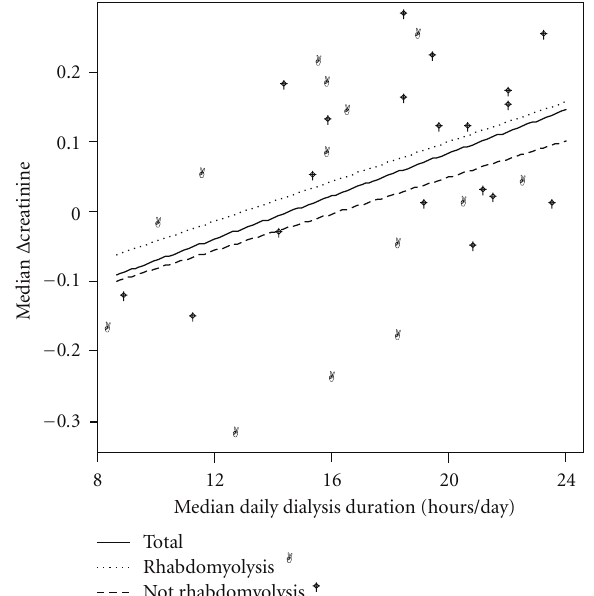
Figure 3: Scattergram of median daily CRRT duration and median Δ creatinine in the total population and the subgroups with and without rhabdomyolysis. Linear regression analysis showed a significant relationship between median daily CRRT duration and median Δ creatinine in the whole group, r = 0 . 43, P = 0 .